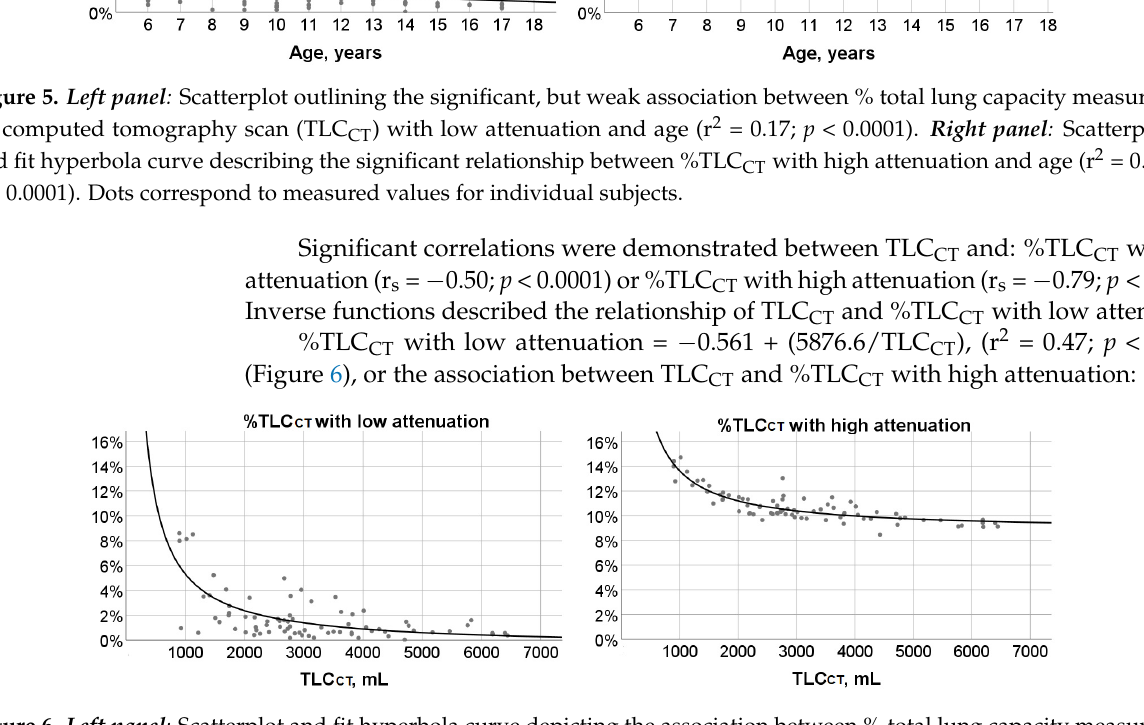
Figure 6. Left panel : Scatterplot and fit hyperbola curve depicting the association between % total lung capacity measured by computed tomography scan (TLC CT ) with low attenuation and TLC CT (r 2 = 0.47; p < 0.0001). Right panel : Scatterplot and fit hyperbola curve describing the significant relationship between %TLC CT with high attenuation and TLC CT (r 2 = 0.76; p < 0.0001). Dots correspond to measured values for individual subjects.